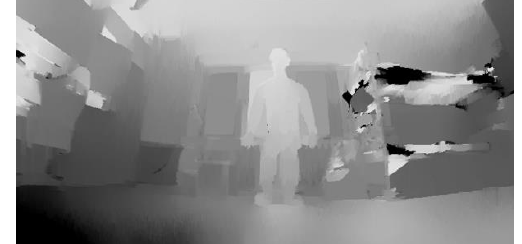
Figure 7. The depth map obtained from the stereogram with optimal